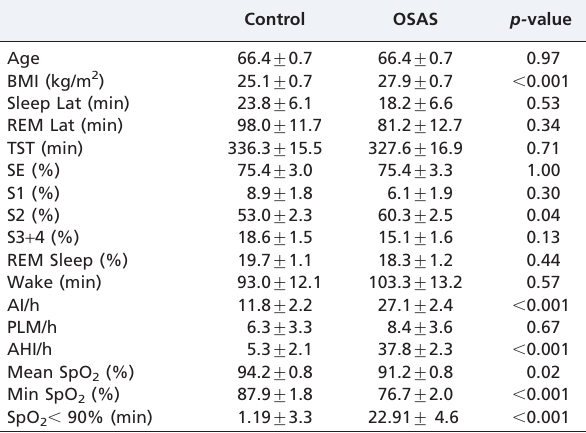
Table 1 - Baseline polysomnographic and clinical data for the control and obstructive sleep apnea syndrome (OSAS) groups.